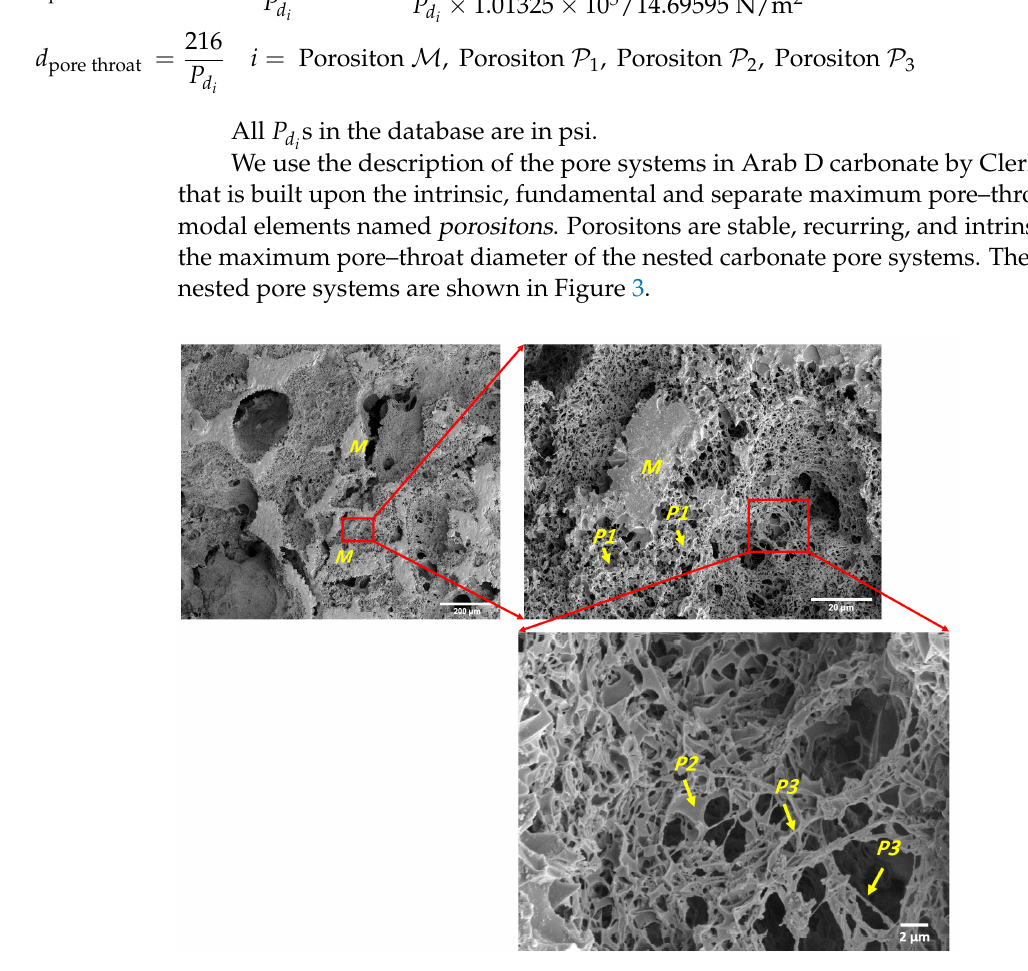
Figure 3. SEM images of the Arab-D pore casts showing the four nested porositons identified by Cantrell and Hagerty [23], namely, M , P 1 , P 2 , and P 3 . The grey solid represents the pore space. Images by Ahmed Hassan